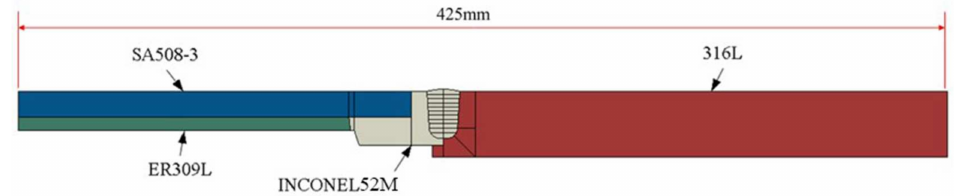
Figure 5. The 2D axisymmetric model of the mock-up with partitions made for different material zones and shown in different